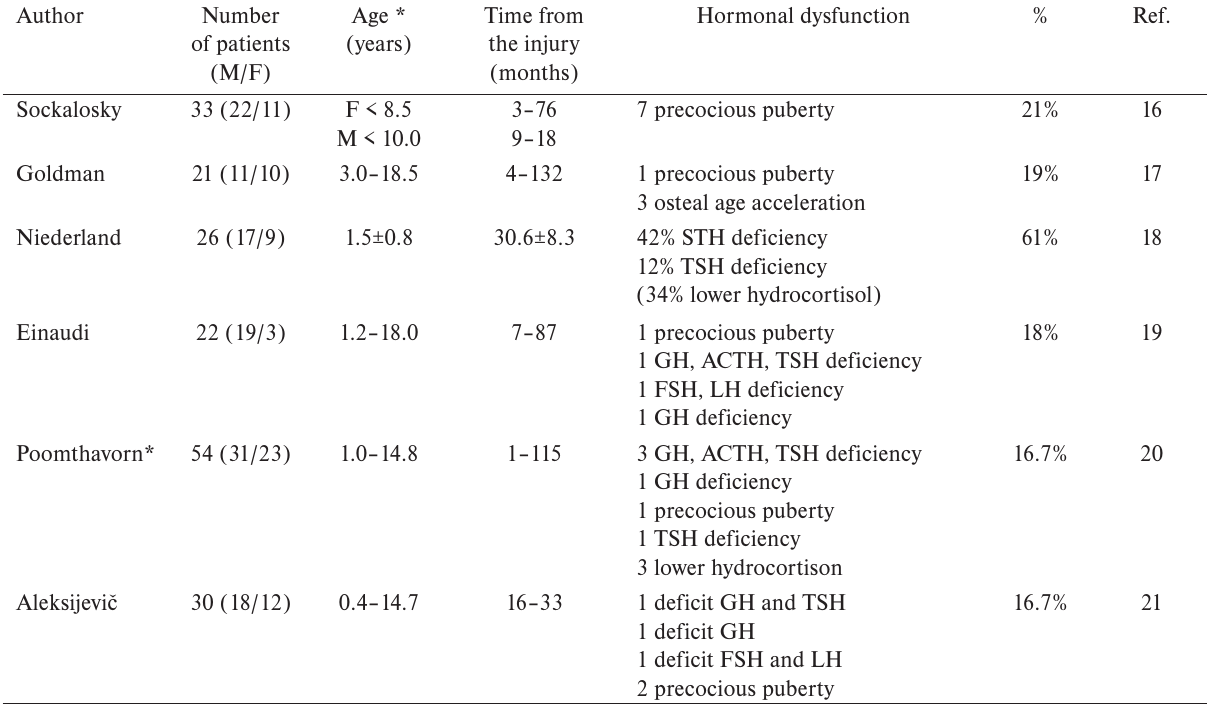
Table 2. Post-traumatic hypopituitarism in